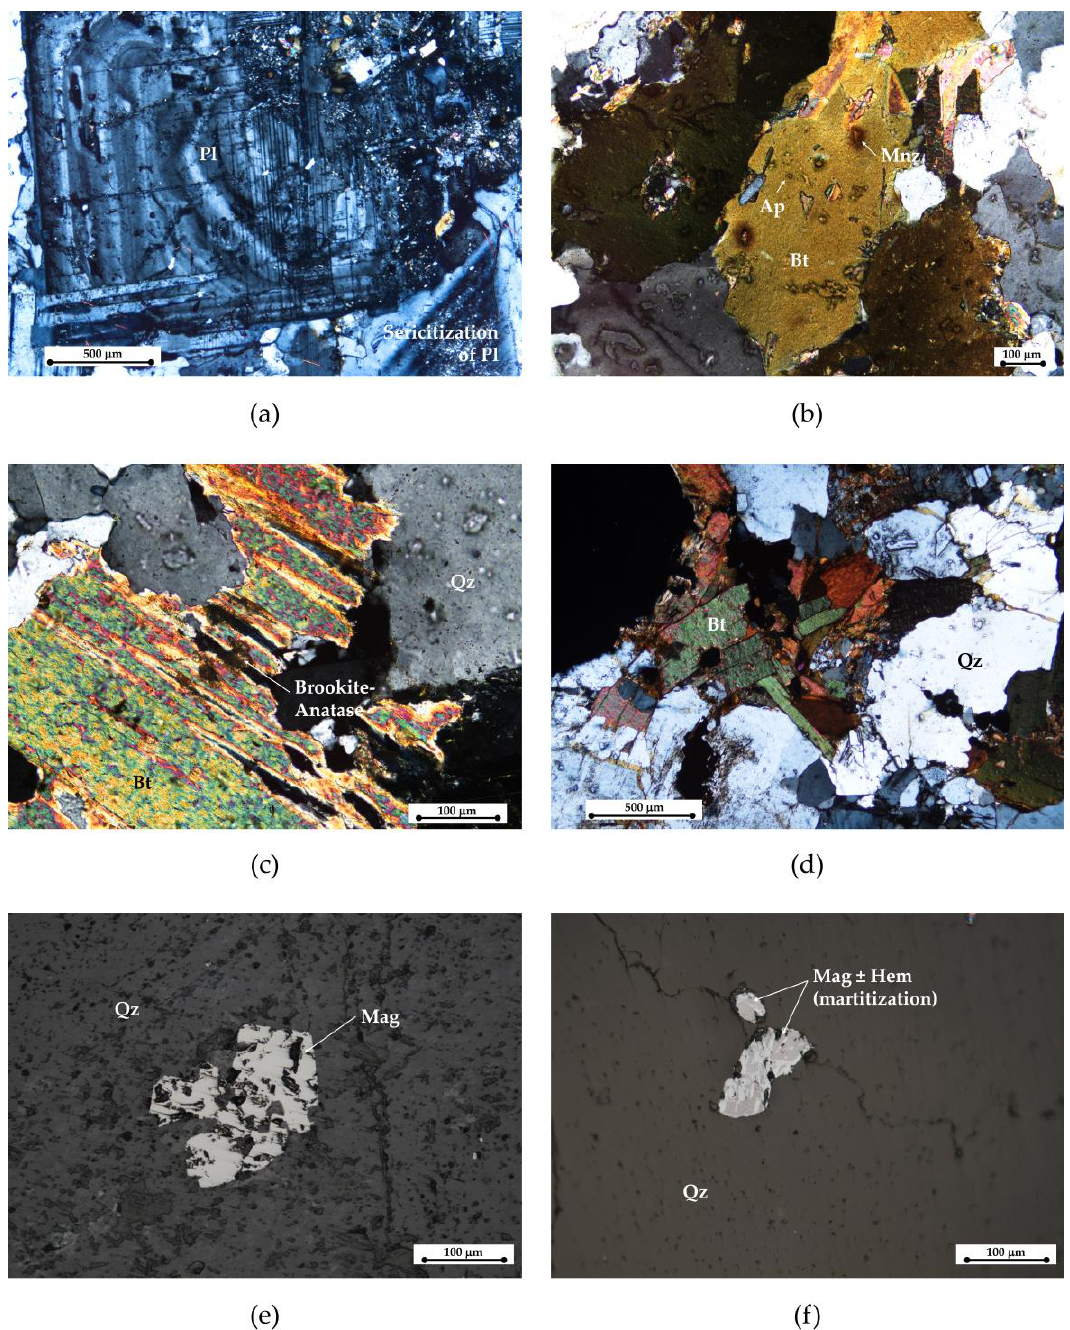
Figure 3. Photomicrographs of the samples observed with transmitted light and reflected light. Transmitted light: ( a ) Plagioclases with oscillatory zoning and sericitization (ES18 sample); ( b ) Biotite with inclusions of monazite and apatite (ES18 sample); ( c ) Biotite with inclusions of brookite-anatase (ES19 sample) ( d ) Curved biotite (ES21 sample). Reflected light: ( e ) Magnetite crystal in quartz (ES87 sample); ( f ) Magnetite partial oxidized to hematite (martite) (ES18 sample). Mineral abbreviations: